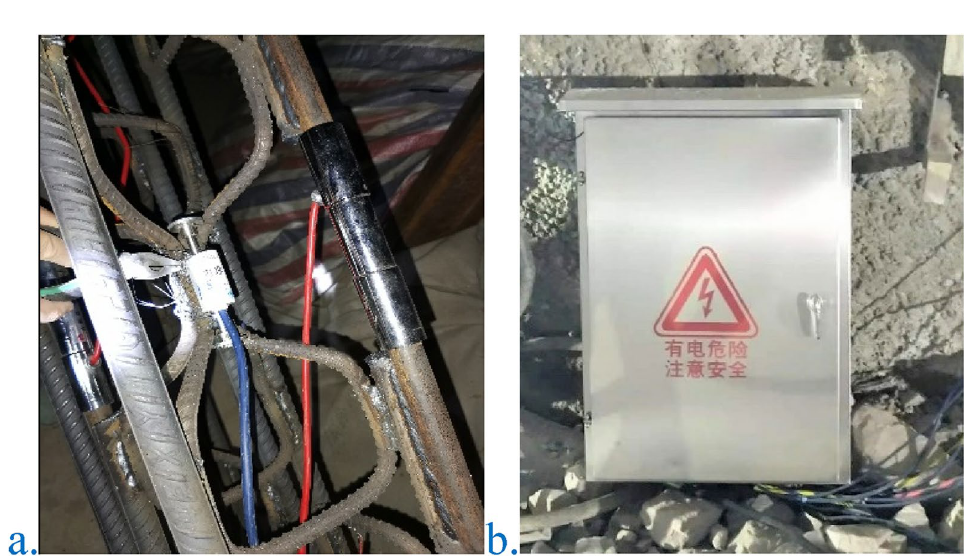
Figure 21. Actual view of the installation of the reinforcement meter and automatic monitoring